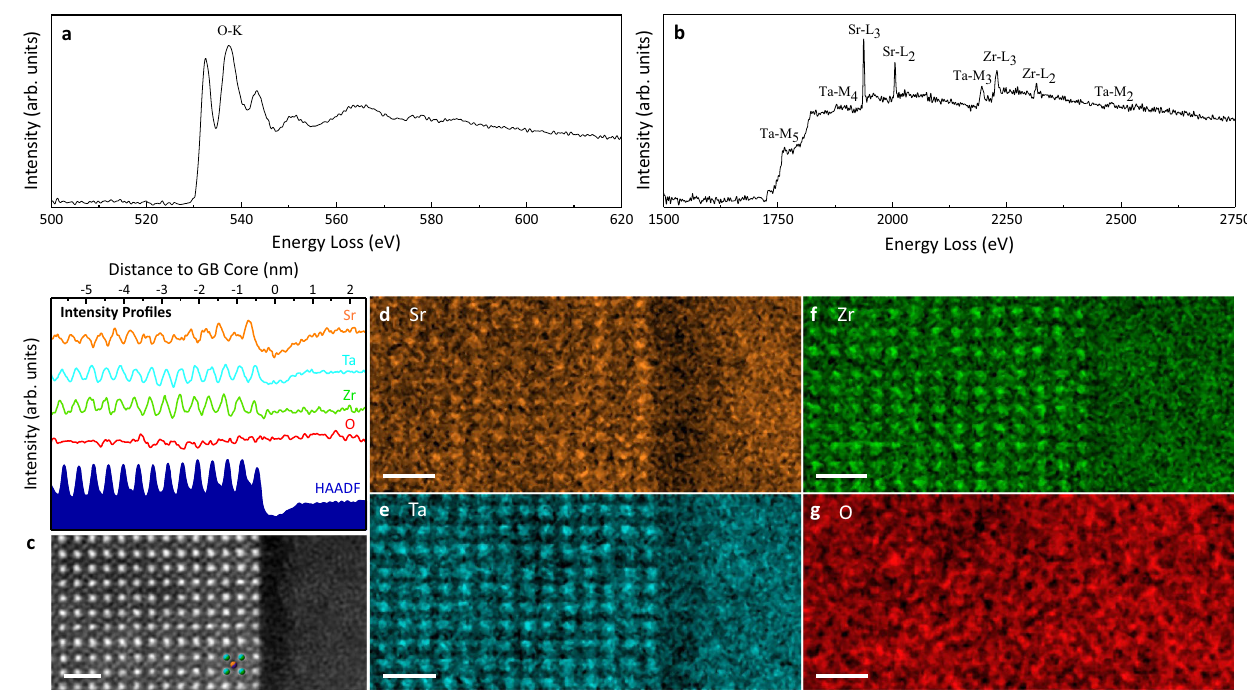
Fig. 3 | Core-loss EELS data of (010) faceted GB. Integrated EEL spectra of a O-K and b Sr-L 2,3 , Zr-L 2,3 , Ta-M 2,3 , and Ta-M 4,5 edges for (010) faceted grain boundary shown in ( c ). c Atomic-resolution HAADF-STEM image of a (010) faceted grain boundary (with respect to the left-side grain). Atoms of a single unit cell (A-site